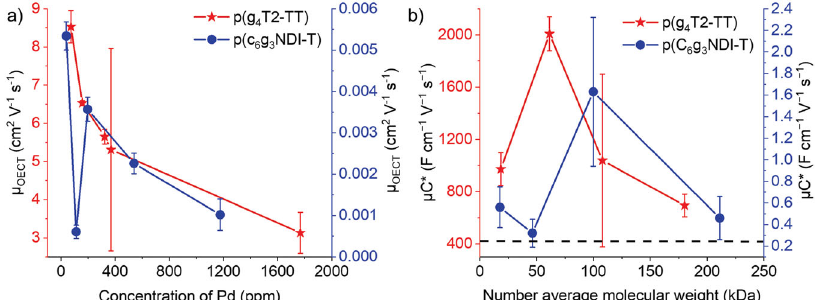
Fig.5|ComparingconcentrationofPdandthemolecularweightwiththeOECT performance. a μ OECT as a function of Pd content in ppm for p(g 4 T2-TT) and p(C 6 g 3 NDI-T) and b [ μ C* ] as a function of M n for p(g 4 T2-TT) and p(C 6 g 3 NDI-T),